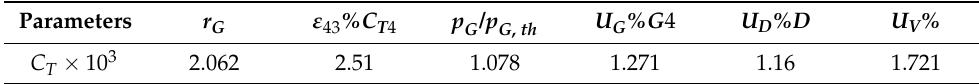
Figure 3. Grid convergence test. Table 3. Verification and validation for the total resistance coefficient.